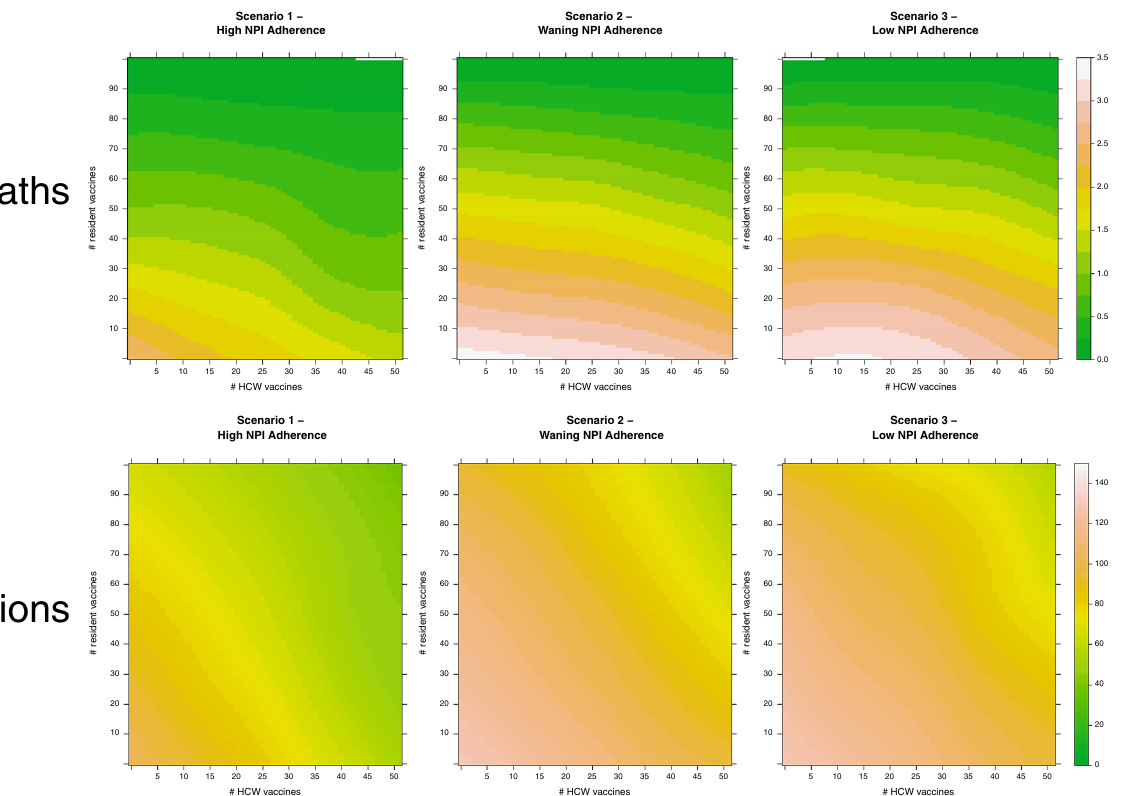
Figure 2. Impact of vaccine coverage on COVID-19 deaths (top row) and infections (bottom row). Heatmaps of the impact of vaccine coverage on COVID-19 deaths (top) and infections (bottom) in simulated long-term care facility populations of 51 healthcare workers and 100 residents for three scenarios with different NPI adherence. Warmer colors indicate more deaths/infections. Per vaccine, vaccinating healthcare workers prevents more deaths when NPI adherence is high (Scenario 1, left), but that impact declines substantially when NPI adherence wanes (Scenario 2, middle) or is low (Scenario 3,